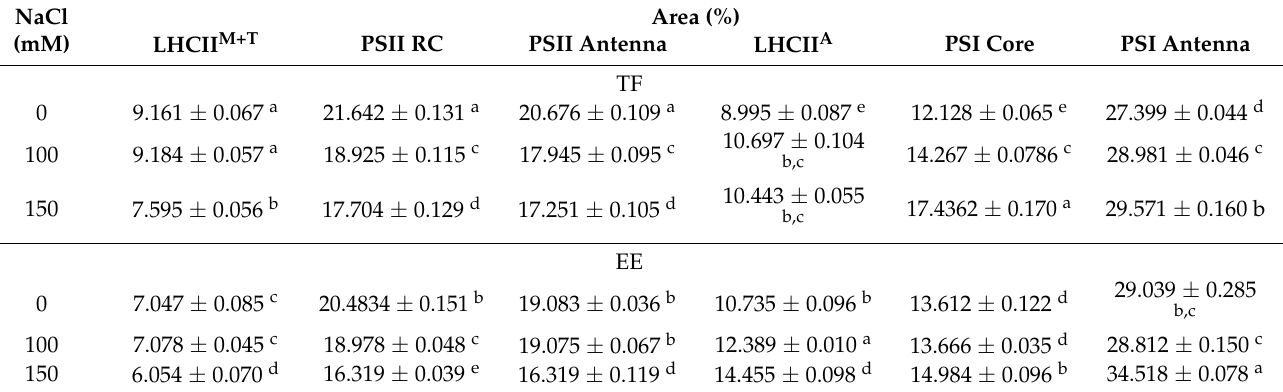
Table 2. Fluorescence emission from the pigment–protein complexes in thylakoid membranes of different NaCl concentrations: fluorescence emitted from monomers ( M ) and trimers ( T ) of LHCII (LHCII A , F 700 ), PSI core (F 720 ) and PSI antenna (F 735 ). The thylakoid membranes were excited